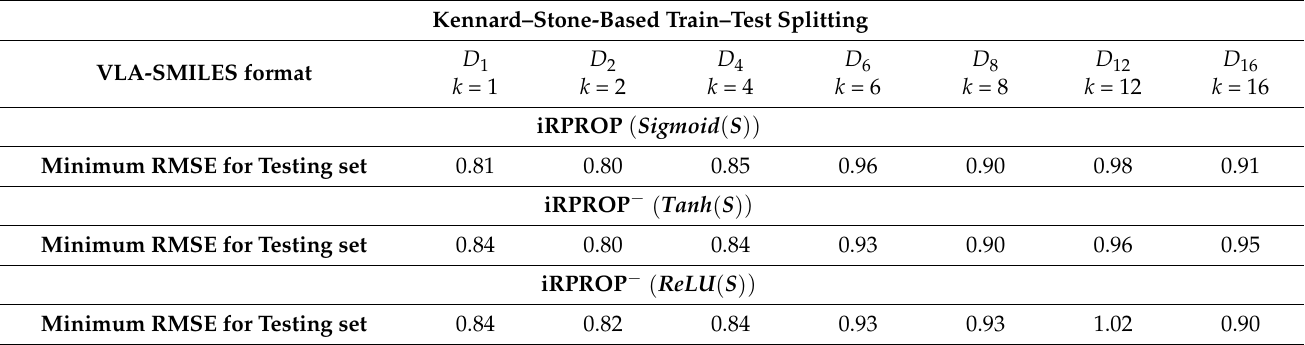
Table 3. RMSE values for testing sets for MLP with one hidden layer using ATransformedBP learning ( Tanh and Sigmoid activation functions, Kennard–Stone based train–test split),